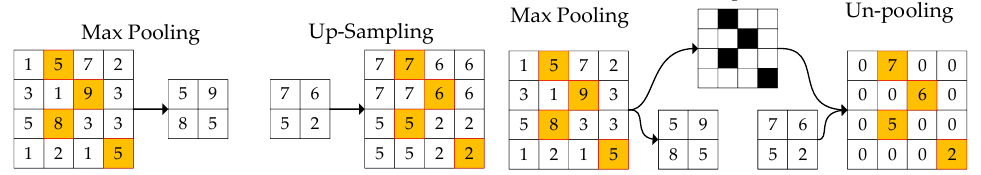
Figure 10. Operating processes of the up-sampling and un-pooling layers.